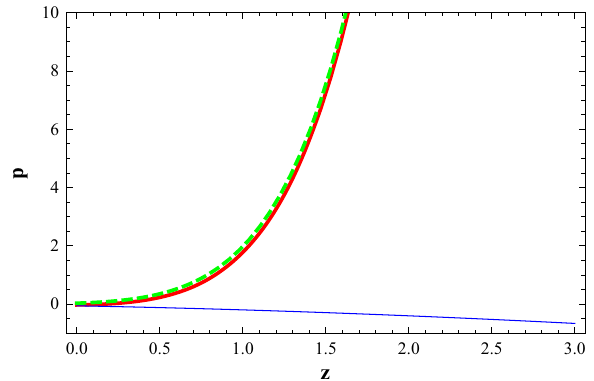
Fig. 3 Evolution of the pressure of the universe in redshift for λ = 0 . 857. The thin (blue) line stands for the usual PF while the dotted (green) line represents the SMF. Effectively, the universe behaves as composed of one fluid, whose pressure is given by the sum of those contributions, as in the thick (red)